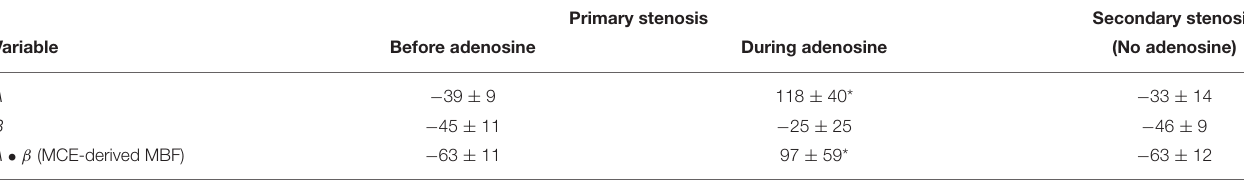
Primary stenosis Secondary stenosis Variable Before adenosine During